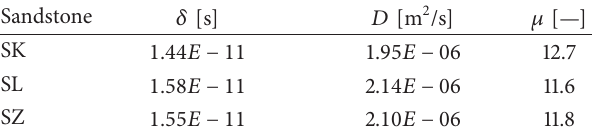
Table 7: Water vapor transport properties, dry cup method.